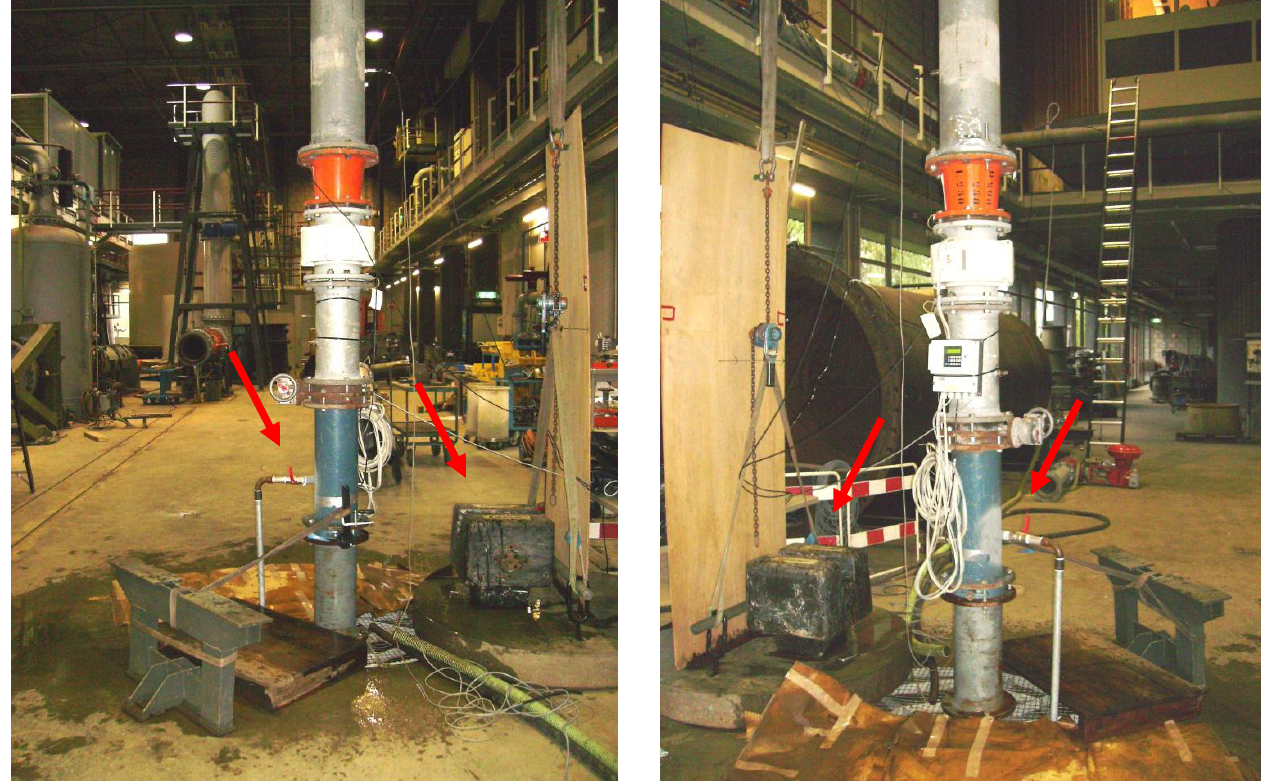
Fig 7. Two other views of the manually operated valve and the heavy mass (see the red